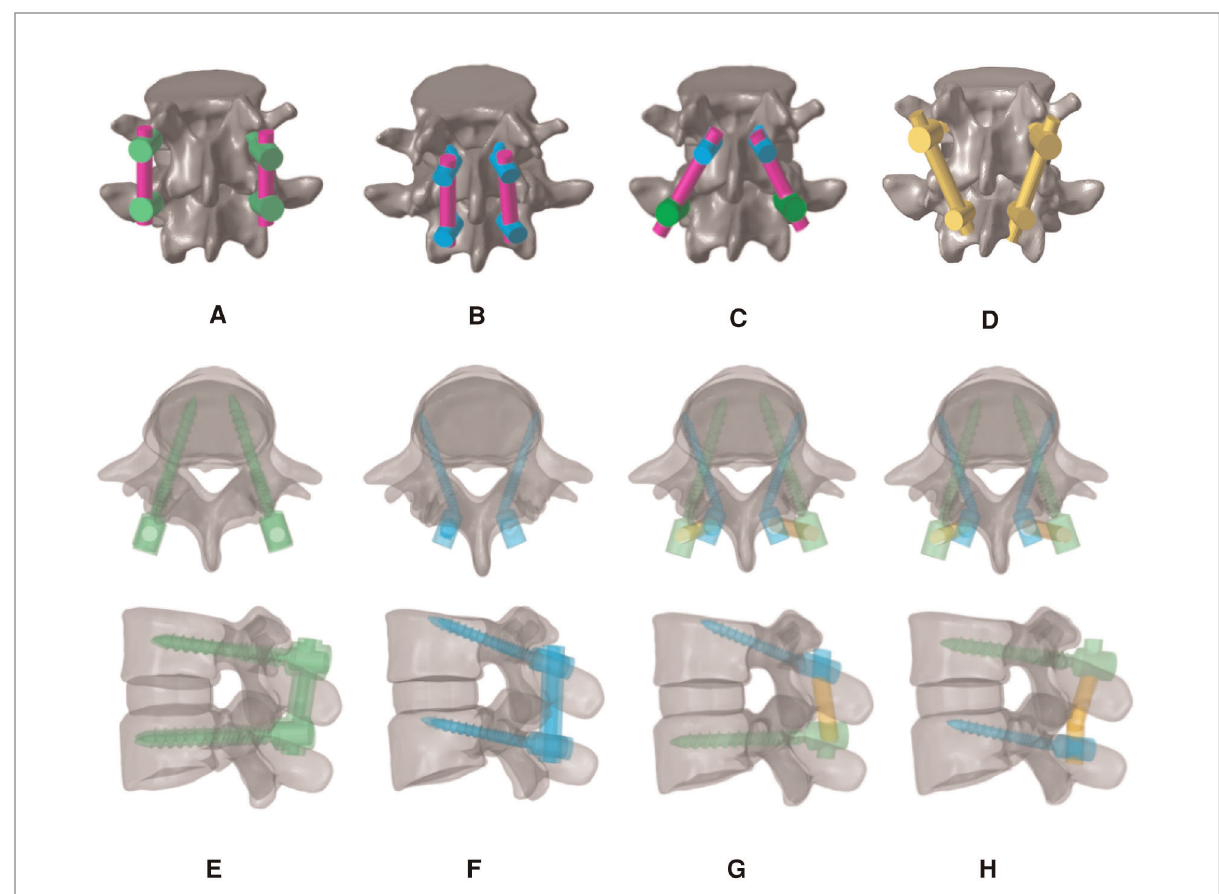
FIGURE 2 FE models of the lumbar vertebra and diagrams from the axial and sagittal views: ( A ) TT screws at the cranial and caudal levels (TT-TT) (19), ( B ) MCBT screws at the cranial and caudal levels (MCBT-MCBT), ( C ) MCBT screws at the cranial level and TT screws at the caudal level (MCBT-TT), ( D ) TT screws at the cranial level and MCBT screws at the caudal level (TT-MCBT), and ( E(19) – H ) were the axial and sagittal views of each respective technique of ( A – D ).